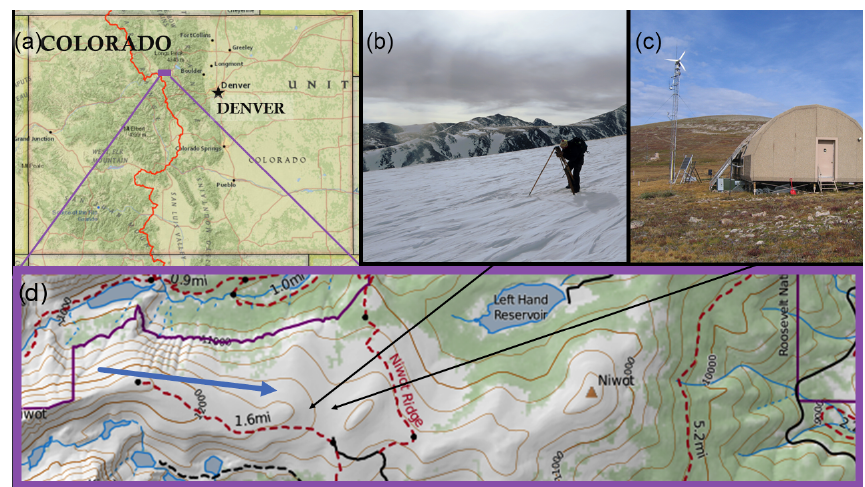
Figure 1. Field site on Niwot Ridge. (a) Location of the field site within the state of Colorado. (b) Installation of a time-lapse camera. (c) Weather station. (d) Close-up map of the field site with arrows showing prevailing wind direction (blue) and the locations of the camera and weather station